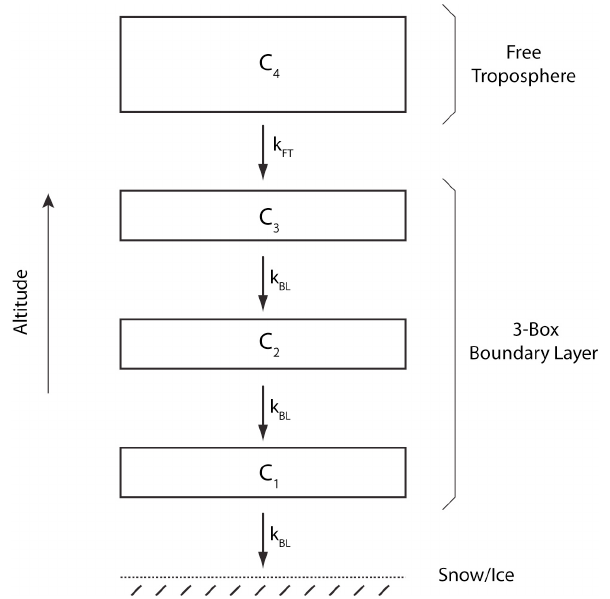
Fig. 10. Conceptual framework for a box model developed to exam- ine the timescales for mixing of BC mass from the free troposphere Figure 10 . Conceptual framework for a box model developed to examine the timescales for 5 into the ABL and to the snow surface. The BC mass loadings in mixing of BC mass from the free troposphere into the ABL and to the snow surface. The BC 6 the free troposphere and ABL are represented by C 4 and C 3 , C 2 , mass loadings in the free troposphere and ABL are represented by and C 1 respectively. The exchange coefficients k same as defined in the Fig. 9